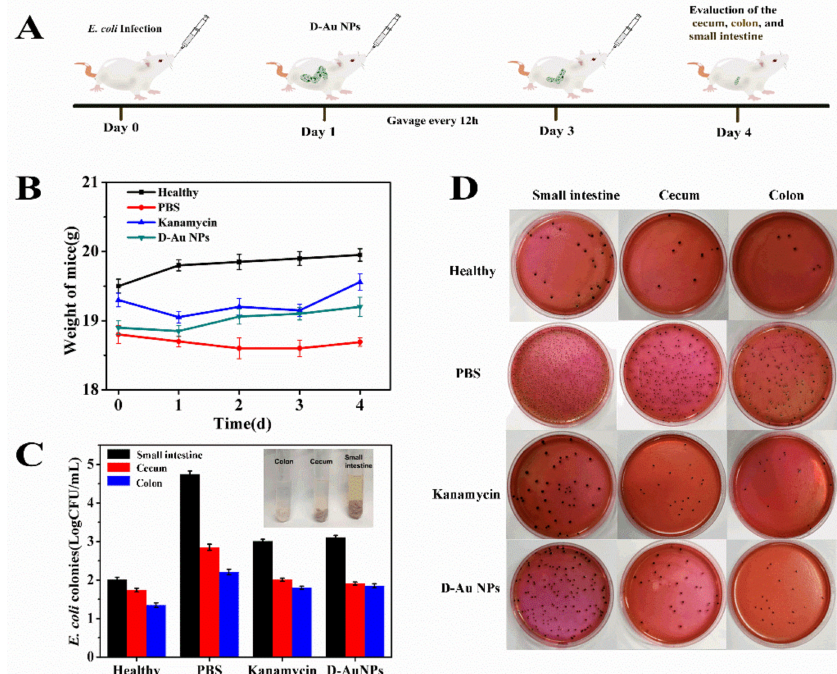
Figure 4. ( A ) Schematic diagram of the in vivo therapy of E. coli infection with D -Au NPs. Mice were evaluated after 3-days of gavage with PBS, D -Au NPs and kanamycin, respectively. ( B ) Changes in body weight in mice during the treatment. ( C ) The survived E. coli in the intestine of the infected mice after different treatments. (Insert: The colon, cecum and small intestine harvested from the infected mice after treatment with D-Au NPs). (Dates are presented as the mean ± s.d.). ( D ) Agar plates showing bacterial colonies of the intestine after different